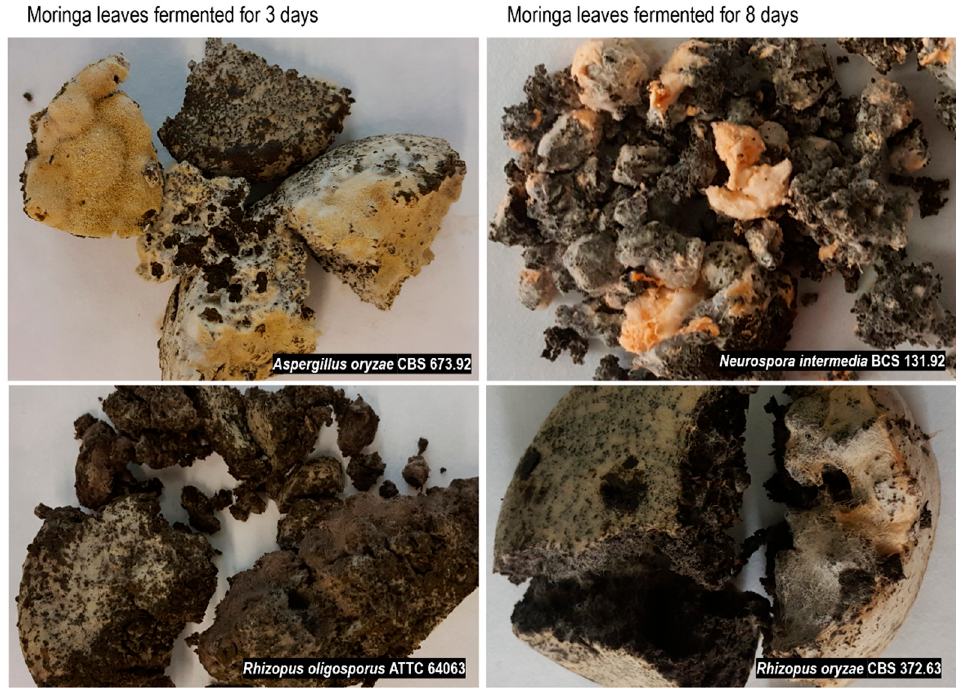
Figure 2. Fermented moringa leaves.